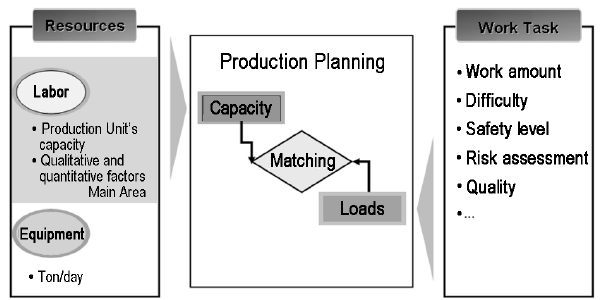
Fig. 2. Production planning